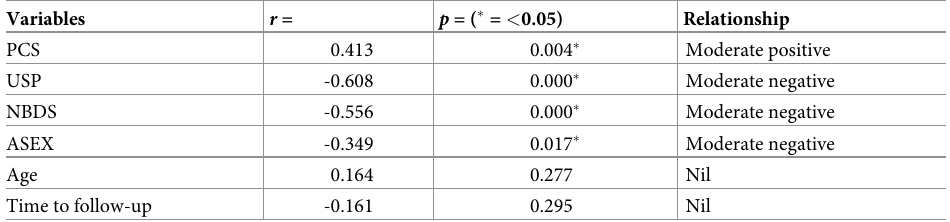
Table 1. Pearson-product moment correlation coefficient between MCS and other